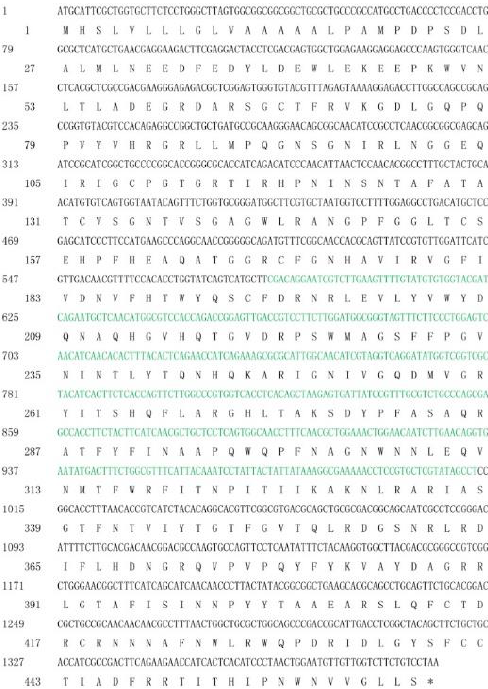
Figure 1. Nucleotide and deduced amino acid sequences of CmdsRNase ( dsRNase from C. medinalis ). The asterisk indicates the stop codon, and the target sequence of RNAi is marked in green (585–1012